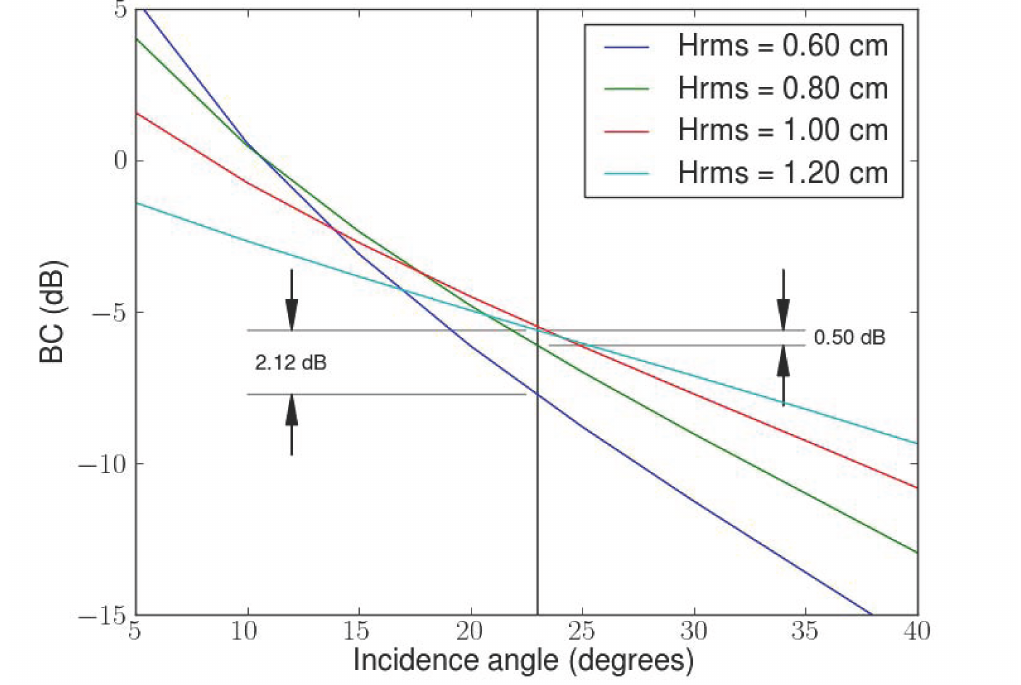
Figure 12. Variation in σ